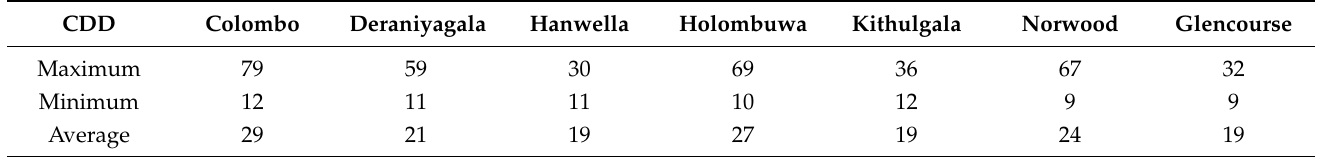
Table 5. CDD statistics from 1961 to 2019 for seven KRB stations.